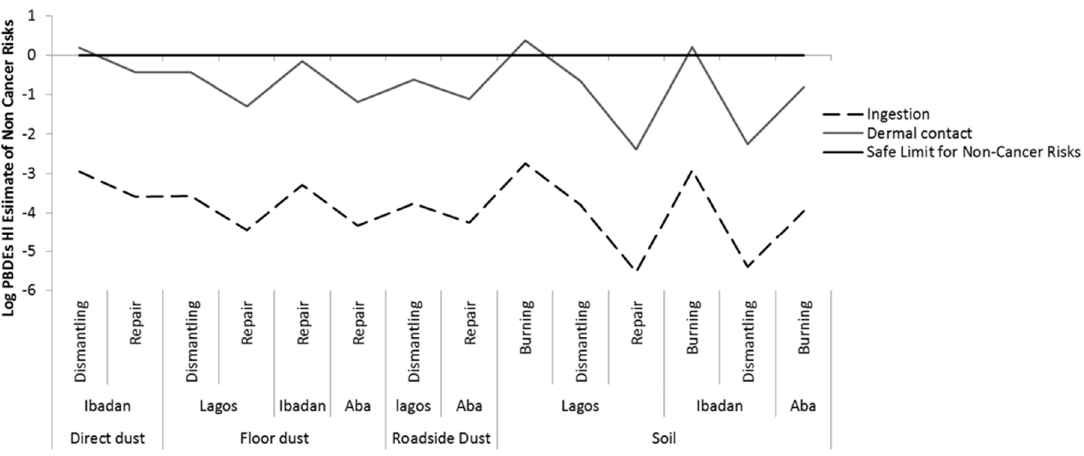
Figure 2. Hazard index (HI) for non-cancer risk via ingestion and dermal contact of Polybrominated Diphenyl Ethers (PBDEs) in soil and dust at various e -waste sites in three locations.